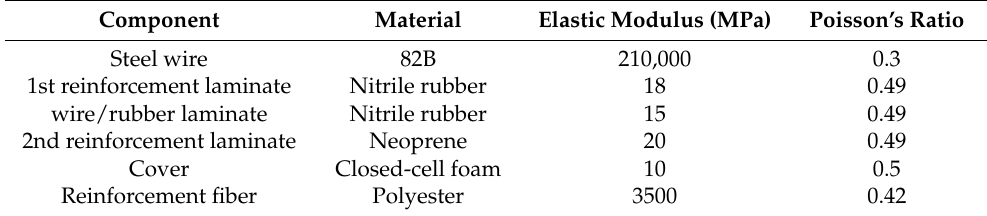
Table 2. Mechanical parameters of the structural components of the